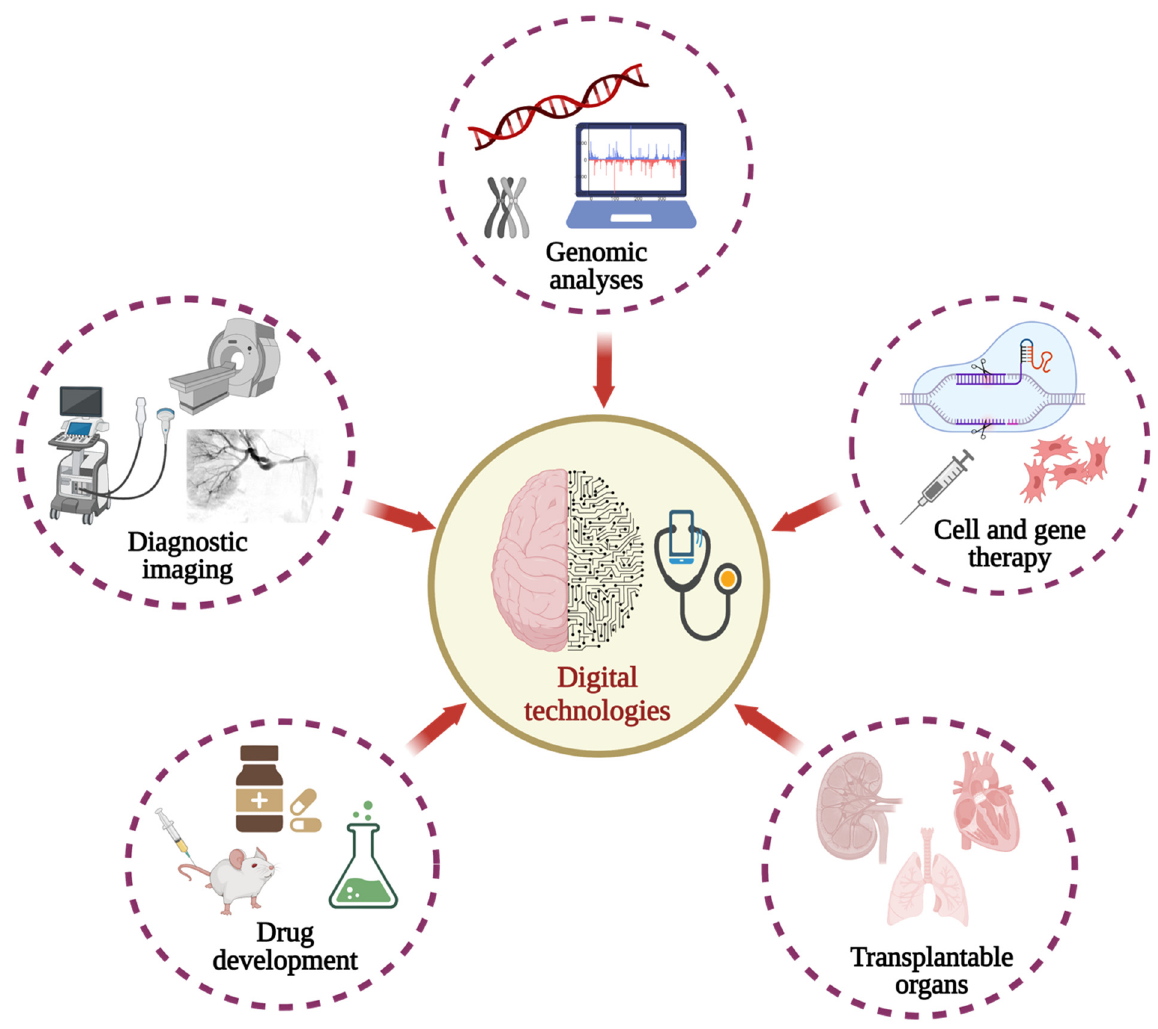
Figure 1. Illustration of digital technologies that are advancing individualized treatments.